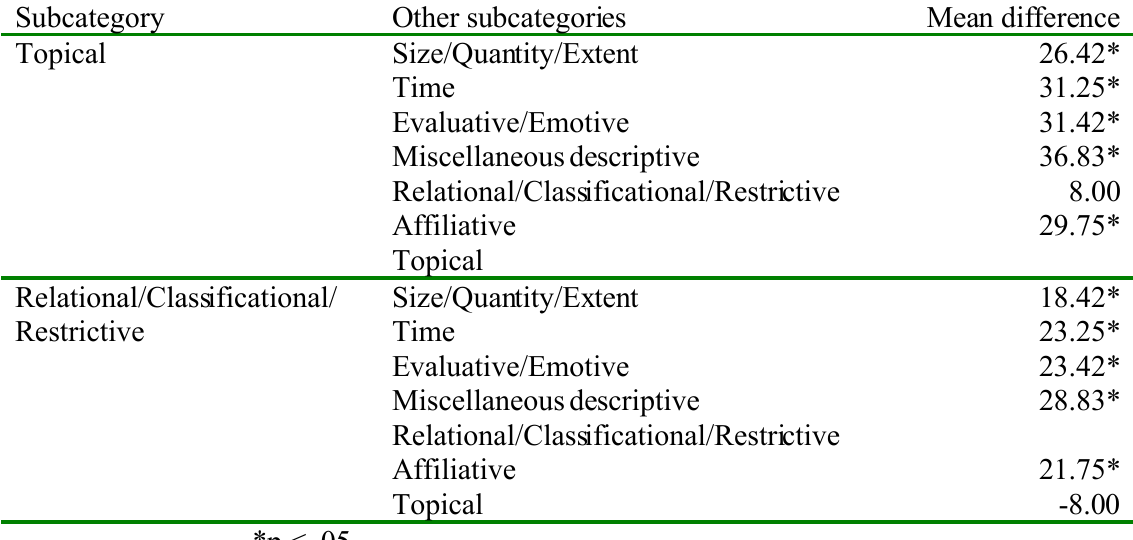
Scheffé Post Hoc Comparisons of Adjective